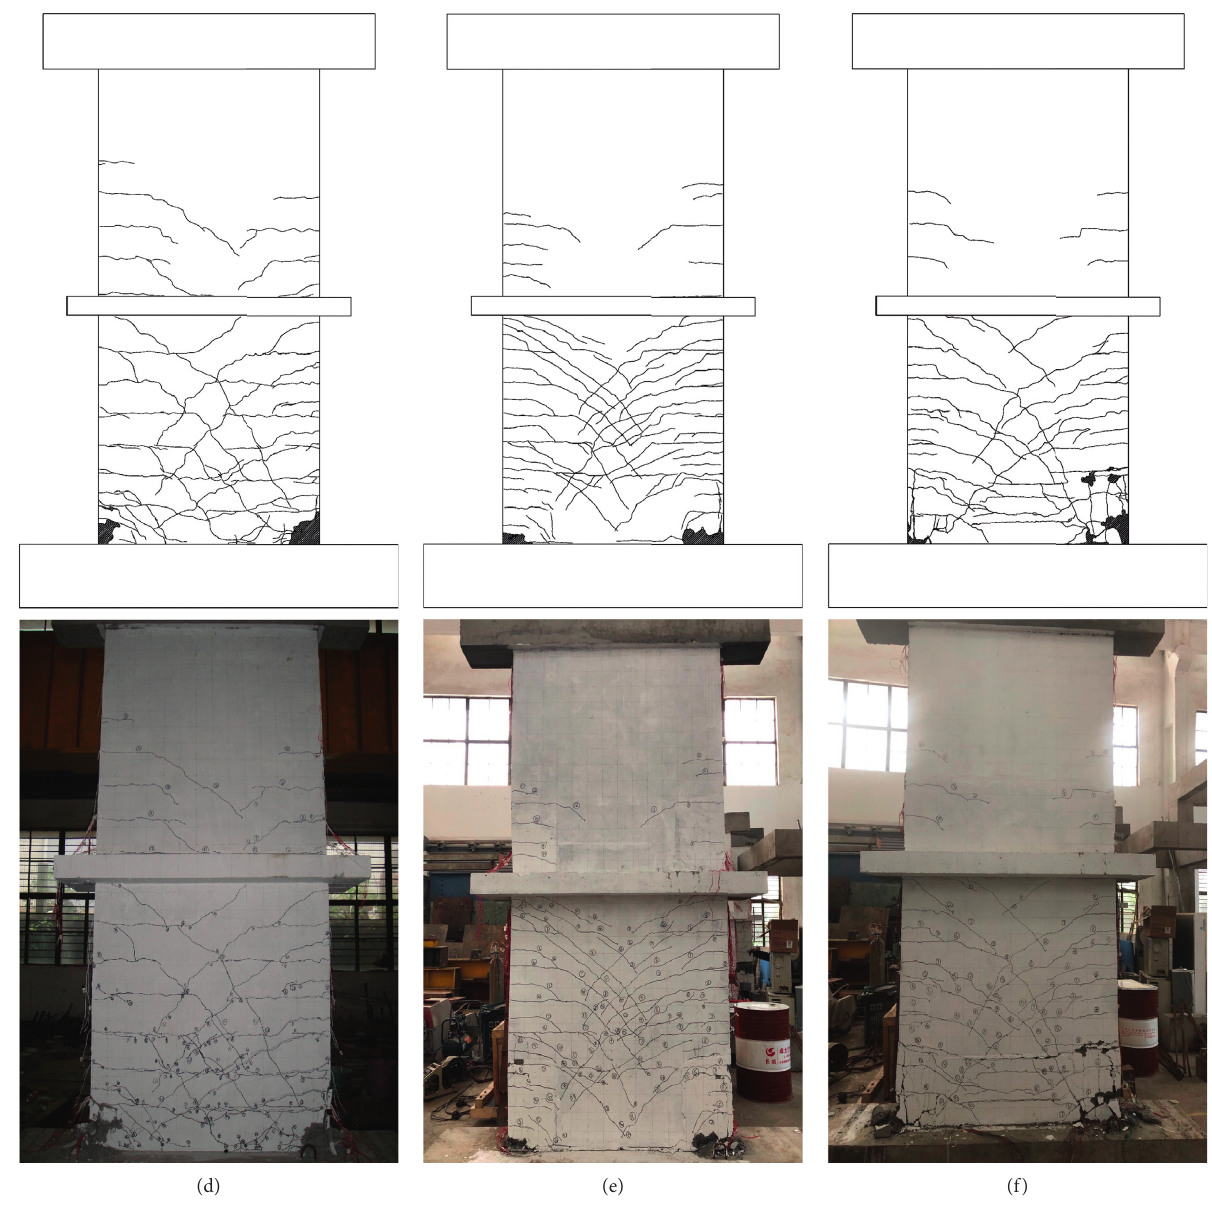
Figure 7: Cracking patterns of specimens. (a) SW1. (b) SRCSW1-1. (c) SRCSW1-2. (d) SW2. (e) SRCSW2-1. (f)